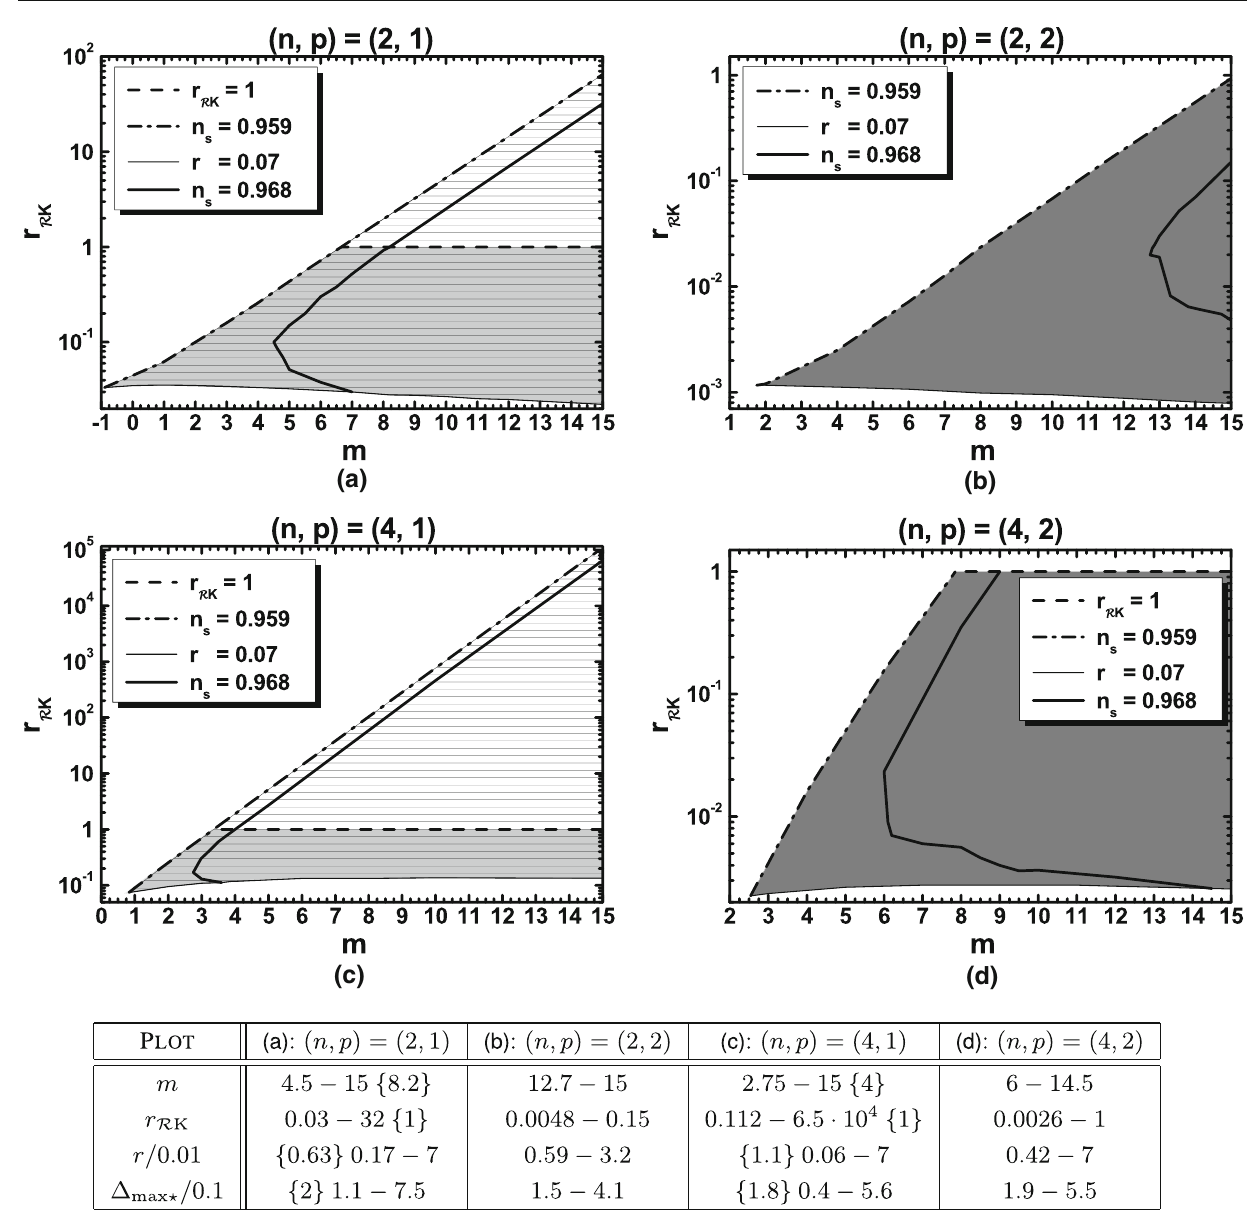
Fig. 2 Allowed (lightly gray and gray shaded) regions in the m − r R K plane for a ( n , p ) = ( 2 , 1 ) , b ( n , p ) = ( 2 , 2 ) , c ( n , p ) = ( 4 , 1 ) and d ( n , p ) = ( 4 , 2 ) . For p = 1 the allowed regions in the panels a and b are extended to the whole lined region for the non-SUSY models and the SUGRA ones employing K = K i with i = 1 ,..., 7. The conventions